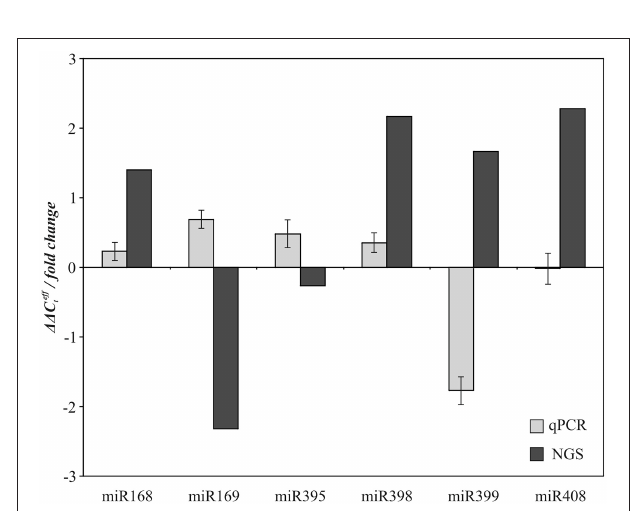
FIGURE 4 | Comparison of NGS and qPCR data on expression alteration of miR168, miR169, miR395, miR398, miR399, and miR408 in P compared to N